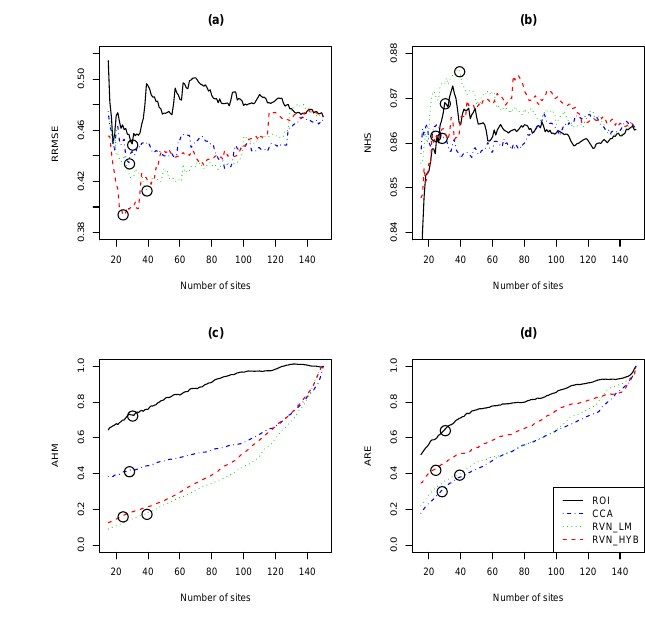
Figure 8. Evaluation criteria for the regression-based model. Cali- brated models are represented by